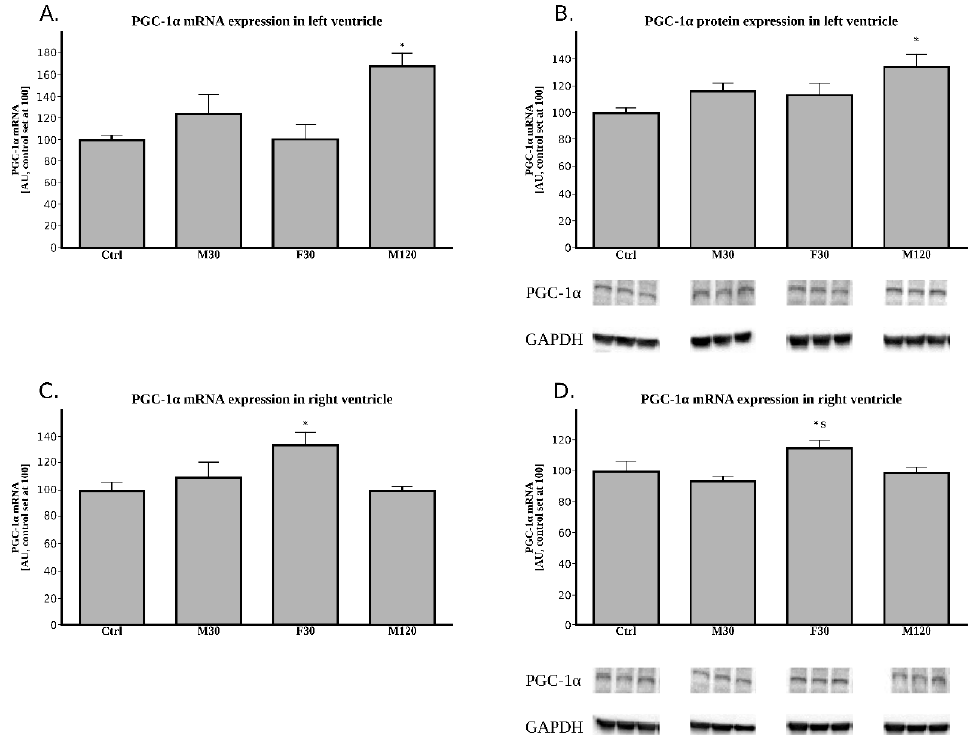
Figure 2. Effects of treadmill running on the peroxisome proliferator-activated receptor gamma coactivator 1-alpha (PGC-1 α ) tissue expression. ( A ) PGC-1 α mRNA expression in left ventricle, ( B )